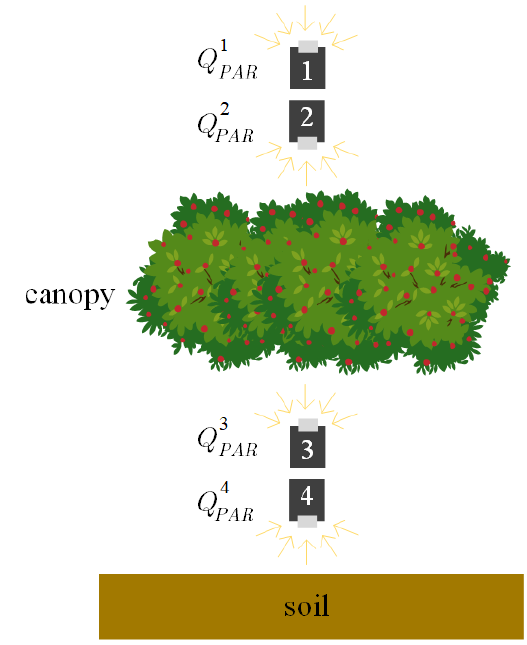
Fig. 10. Noise-equivalent circuit of the TIA.